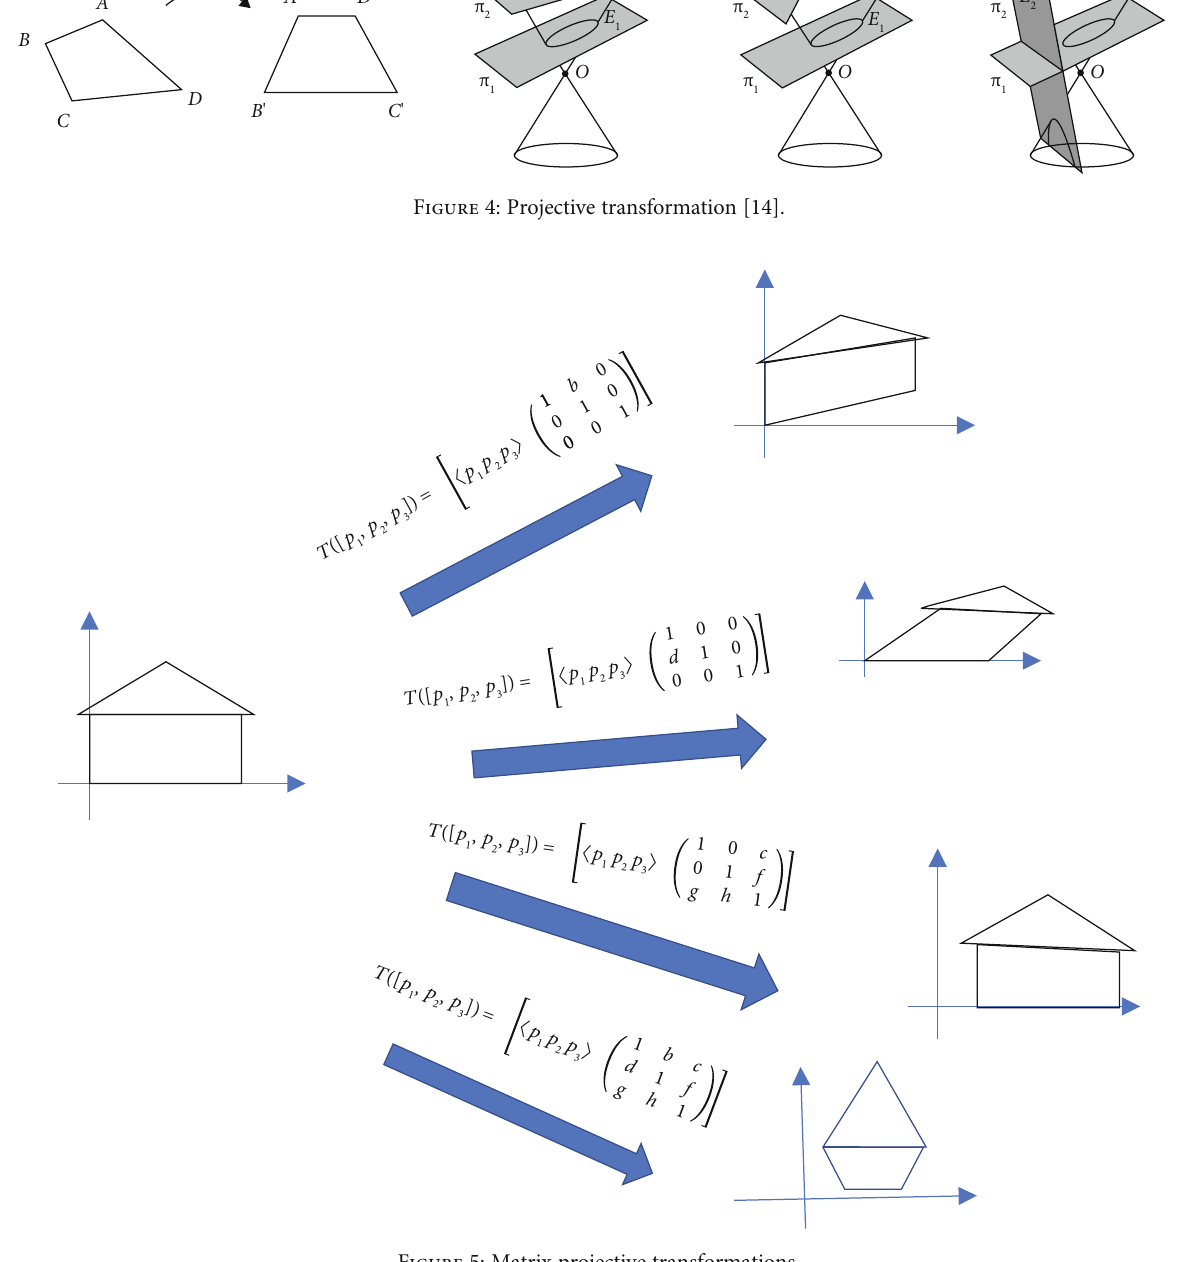
Figure 5: Matrix projective transformations.